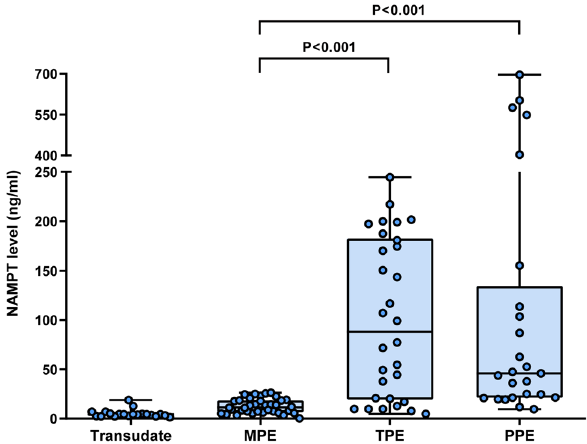
Figure 1. Distribution of pleural fluid NAMPT levels in the different diagnostic groups. MPE malignant pleural effusion, TPE tuberculous pleural effusion, PPE parapneumonic effusion.